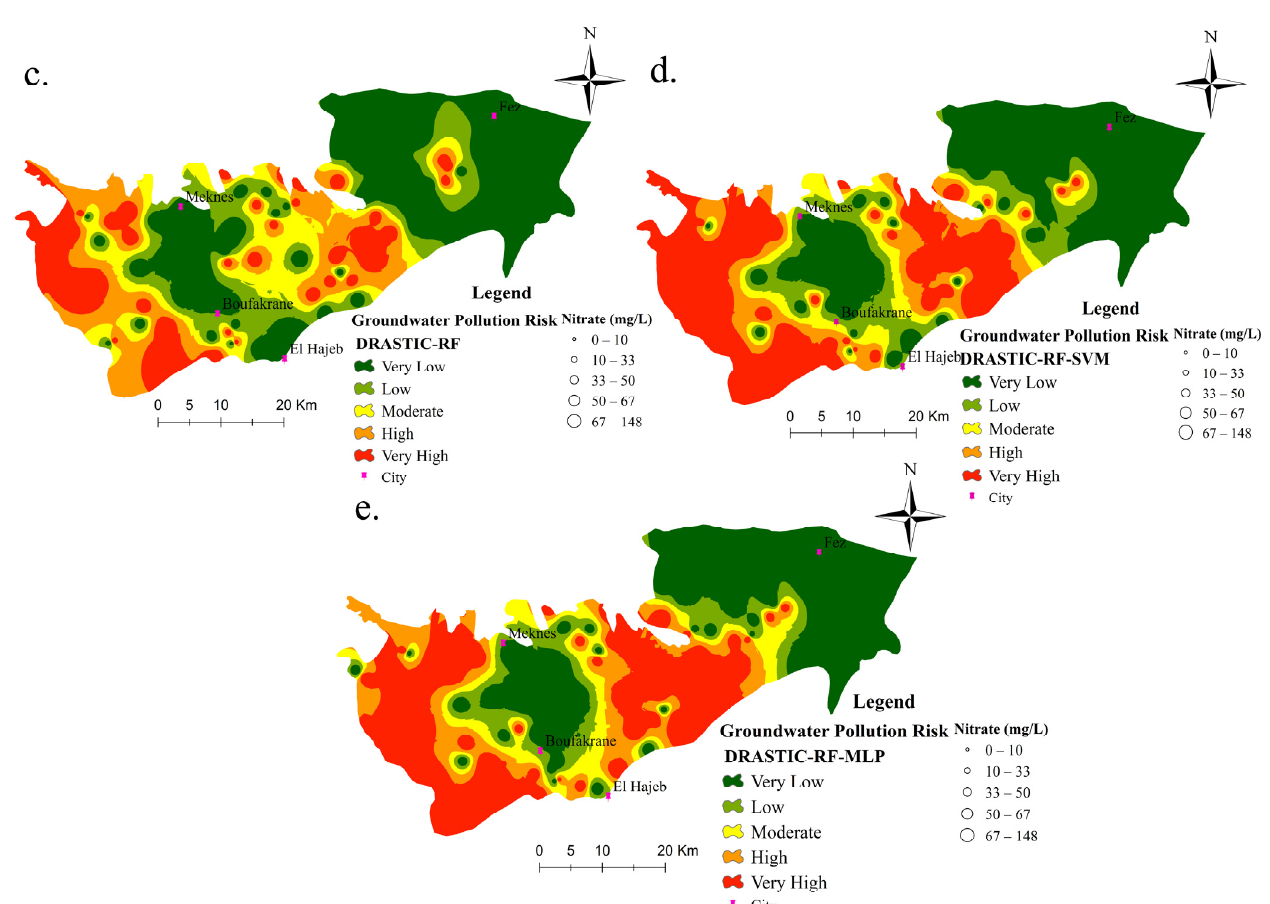
Figure 7. Groundwater pollution risk maps using the ML models: ( a ) DRASTIC-MLP, ( b ) DRASTIC- SVM, ( c ) DRASTIC-RF, ( d ) DRASTIC-RF-SVM and ( e ) DRASTIC-RF-MLP. SVM, ( c ) DRASTIC-RF, ( d ) DRASTIC-RF-SVM and ( e )